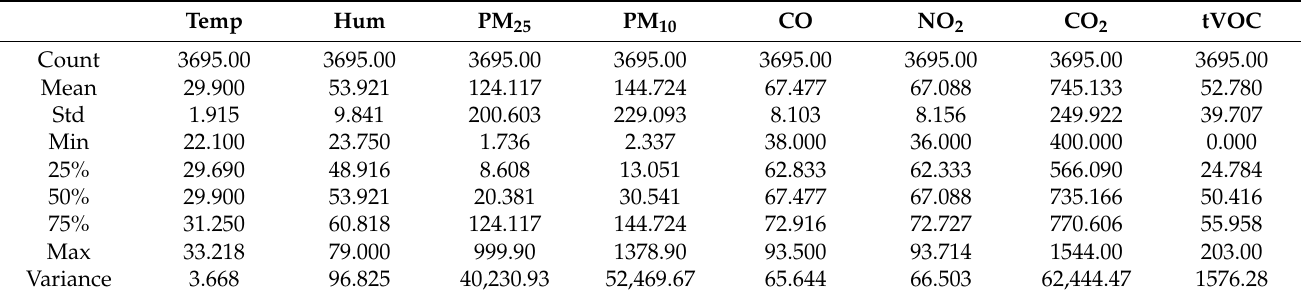
Table 2. Statistical information about measured and pre-processed field